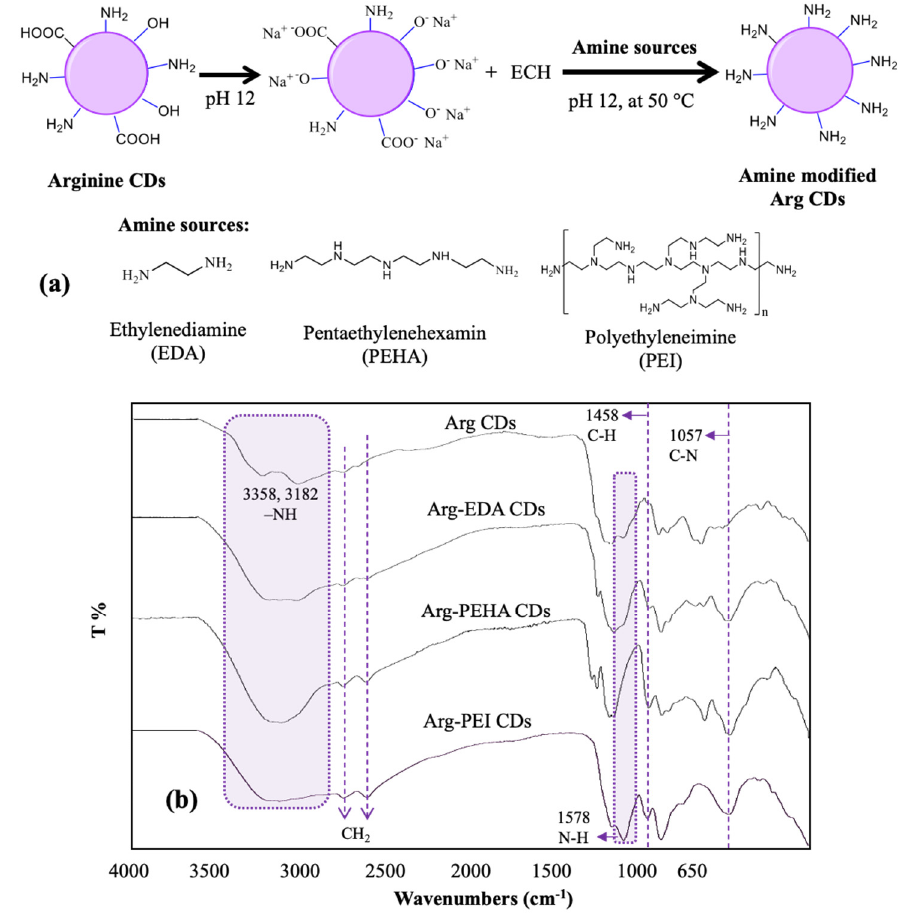
Figure 2. ( a ) Schematic representation of modification reaction of arginine CDs with different amine sources such as ethylenediamine (EDA), triethylenetetramine (TETA), pentaethylenehexamine (PEHA), and polyethyleneimine (PEI), and ( b ) FT-IR spectrum of arginine CDs and modified arginine-PEI CDs. Table 1. Zeta potential values of arginine CDs and its amine-modified forms with different amine